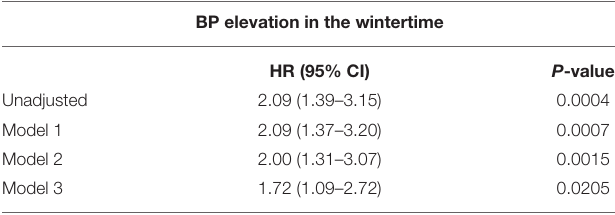
TABLE 7 | Hazard ratios for relationship between BP elevation in the wintertime and poor outcome (eGFR decline ≥ 40%, dialysis, transplantation, or death) in 288 CKD patients with home BP